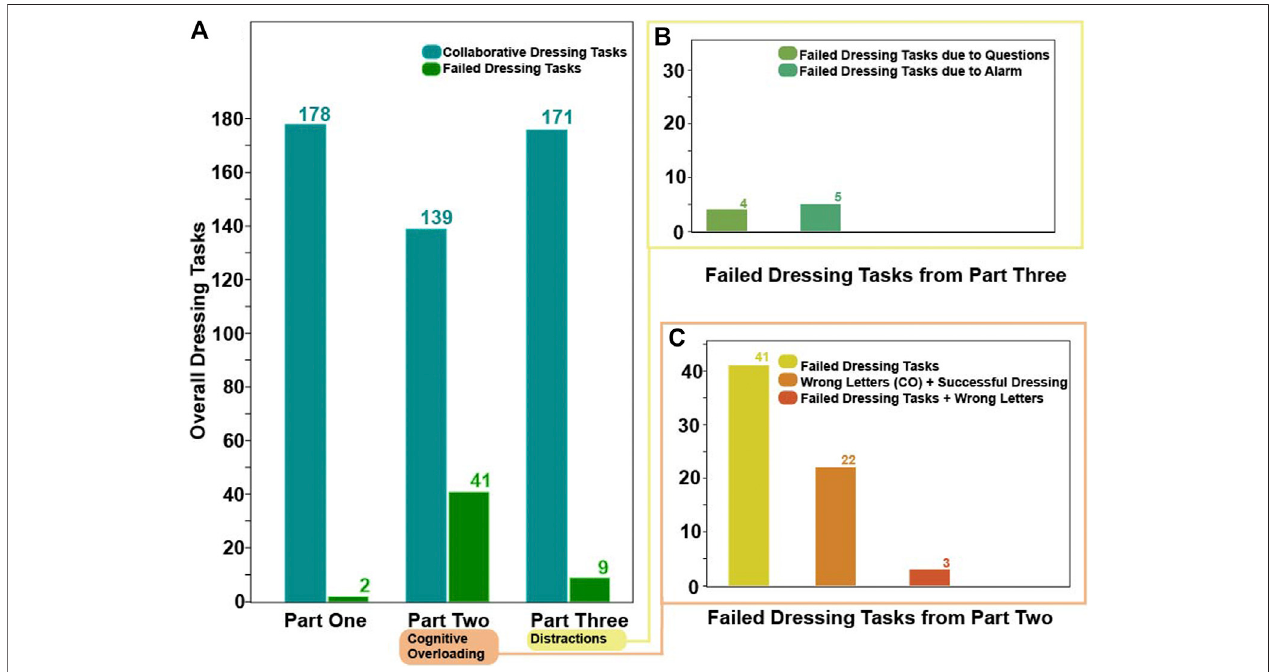
FIGURE4| Dressing failureand mistakes count in thedifferent parts oftheHRI experiment. (Panel A) shows the dressing failure in PartOne. (Panel B) shows the dressing failures that occurred in Part Three. (Panel C) shows the dressing failures and mistakes that occurred during the cognitive overloading in Part Two.